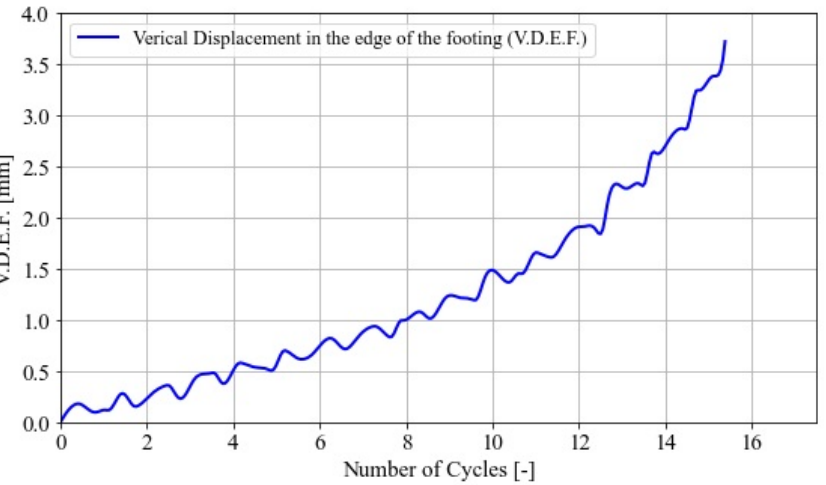
Figure 11. Vertical displacement on the edge of the footing versus the number of cycles. The sample shows the number of cycles at overturning for Ottawa sand at 5.86 Hz and an amplitude of 0.2 mm on the edge of the footing.